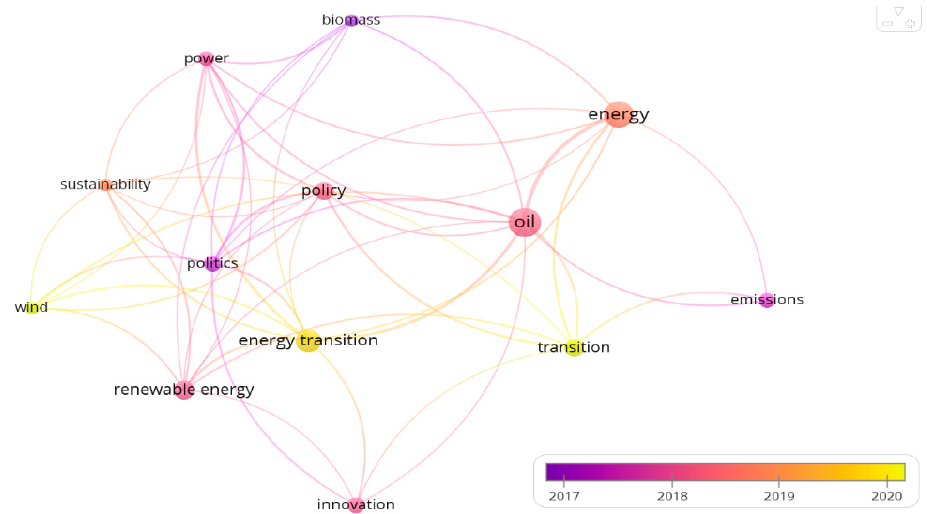
Figure 2. Common words in scientific publications (Source: authors based on WoS’s articles ana ‐ lysed).